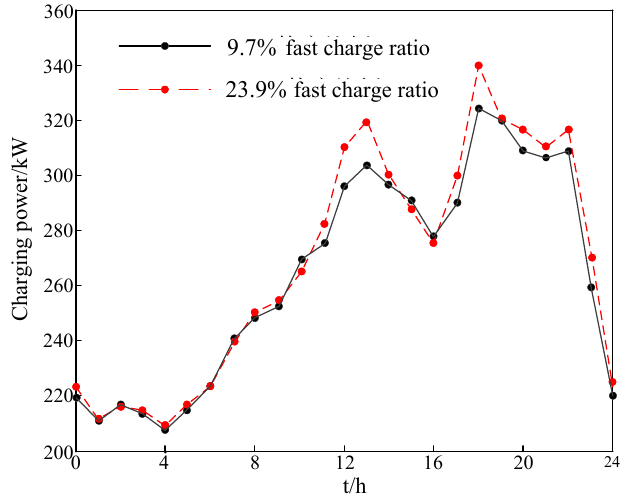
Figure 6. Charging load curve for different fast charge ratios.